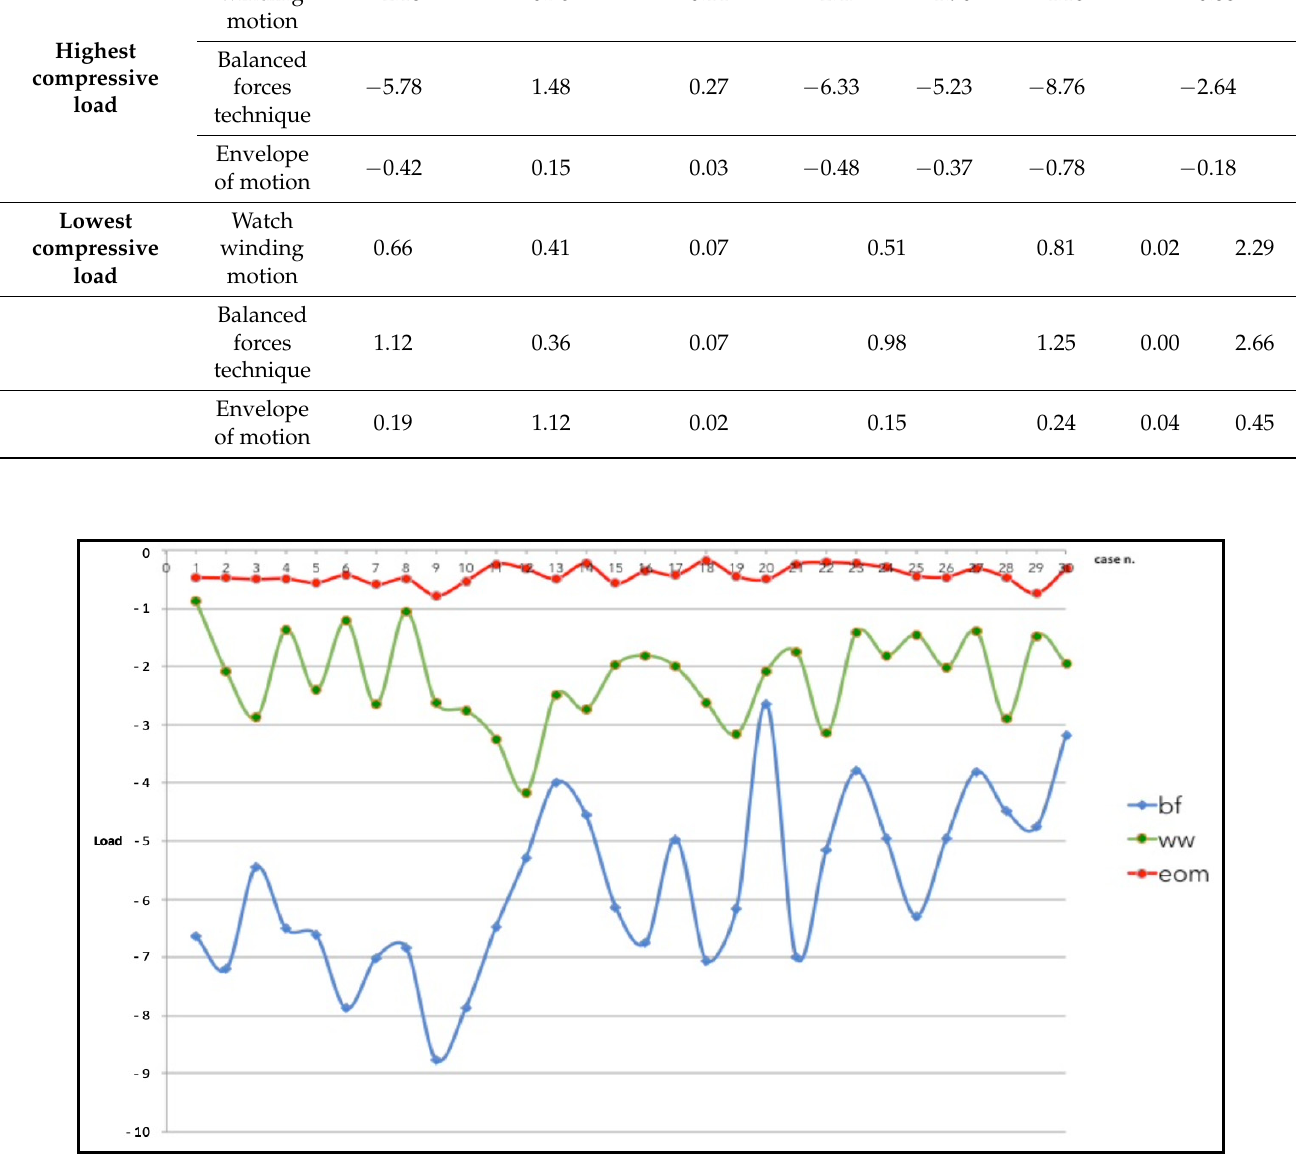
Table 2. Descriptive statistical analysis of the watch winding motion, balanced forces technique, and envelope of motion, each on 30 tooth models, by the highest and lowest compressive loads (N). Standard Standard 95% Confidence Min. Max. Mean Deviation Error Intervals for the Mean − 2.18 0.76 0.14 − 2.47 − 1.90 − 4.16